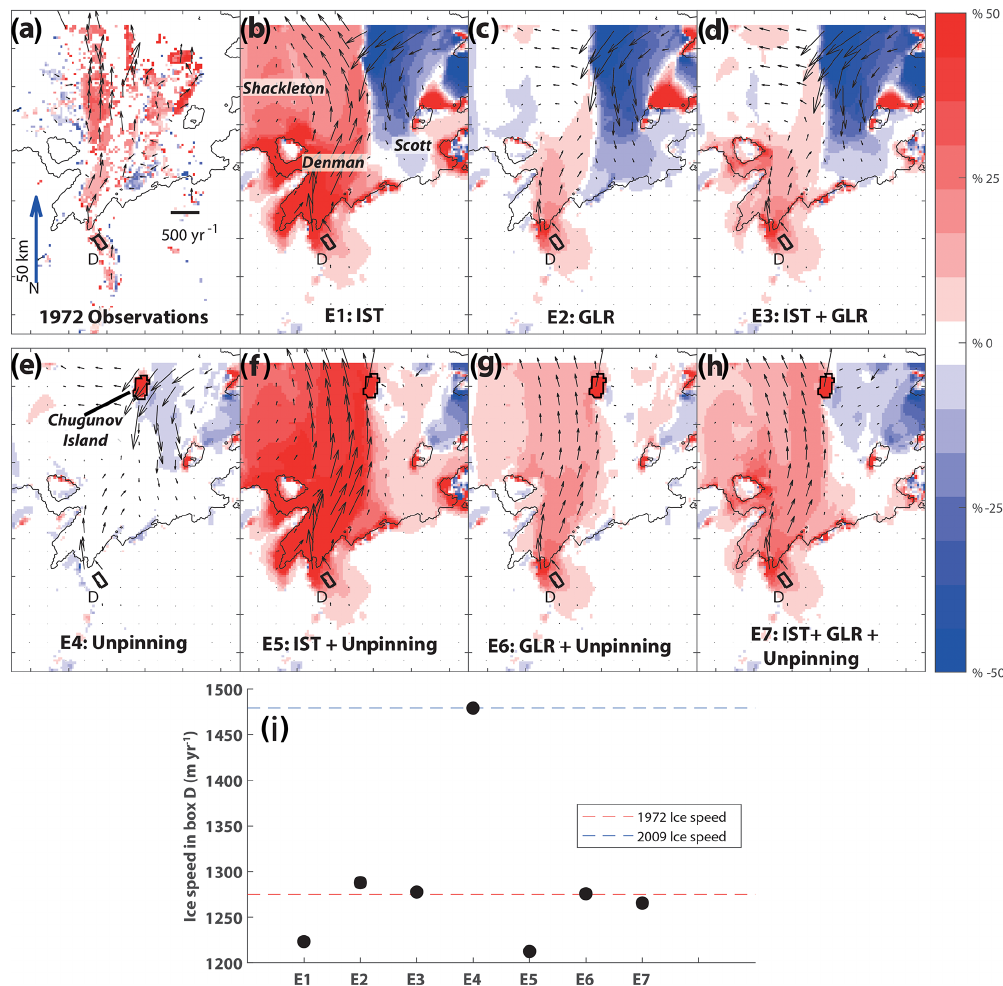
Figure 5. The effect of varying ice geometry on ice flow: ice velocity difference between 2009 observations and (a) observations from 1972; (b–h) seven experiments which perturb 2009 ice geometry to represent possible 1972 ice geometry configurations. In each experiment combinations of ice shelf thinning (IST), grounding line retreat (GLR) and the unpinning from Chugunov Island are perturbed (see Table 1). Note that red indicates areas where ice flowed faster in 2009, and blue indicates areas flowing slower, with arrows showing the direction and magnitude of change when compared to the 1972 perturbations. (I) Mean speed from box D in each experiment; the dotted red line represents the observed mean speed from box D in 1972, and the blue line represents observed speed from 2009. E7 most closely matches the speed observed in box D , the spatial pattern of the observed acceleration and the westward bending of Denman’s ice